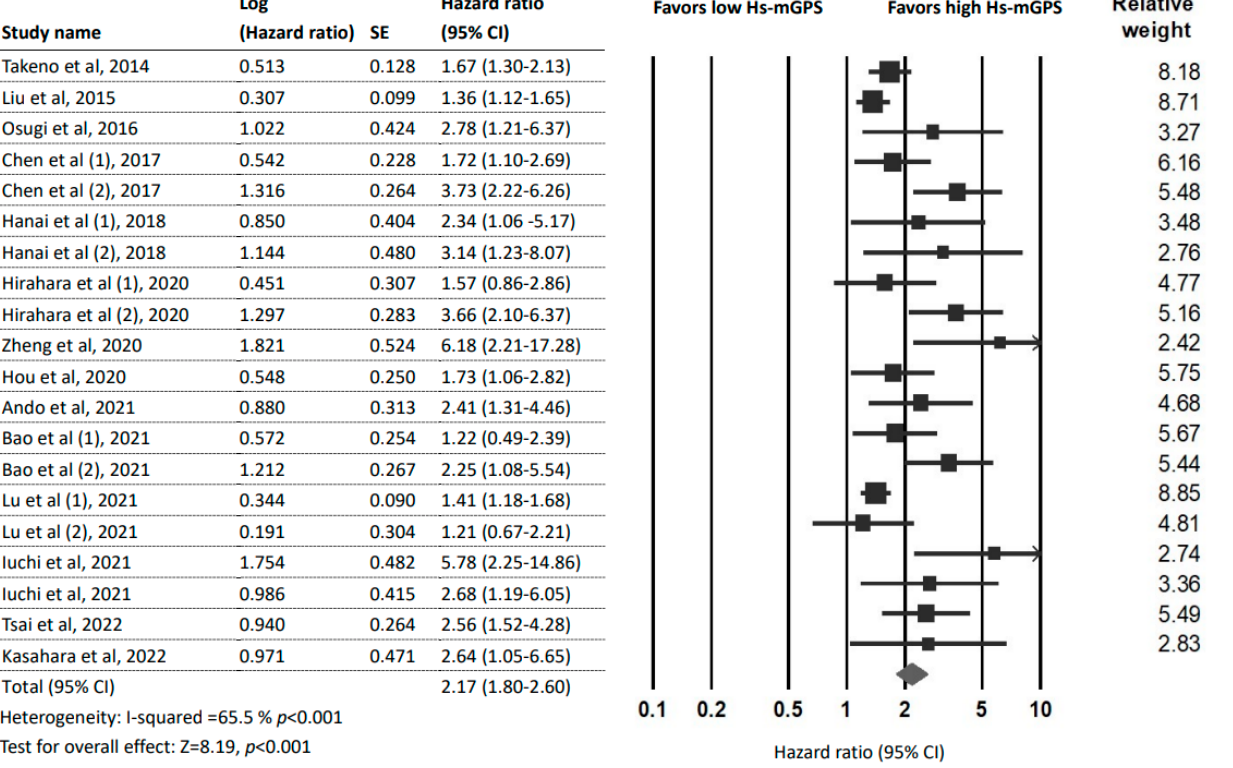
Figure 2. Forest plot indicating the pooled HRs to assess the influence of the HS-mGPS on OS. Ab- breviations: HR, hazard ratio; CI, confidence interval; HS-mGPS, high-sensitivity modified Glasgow Prognostic Score [7,14–16,22–32].